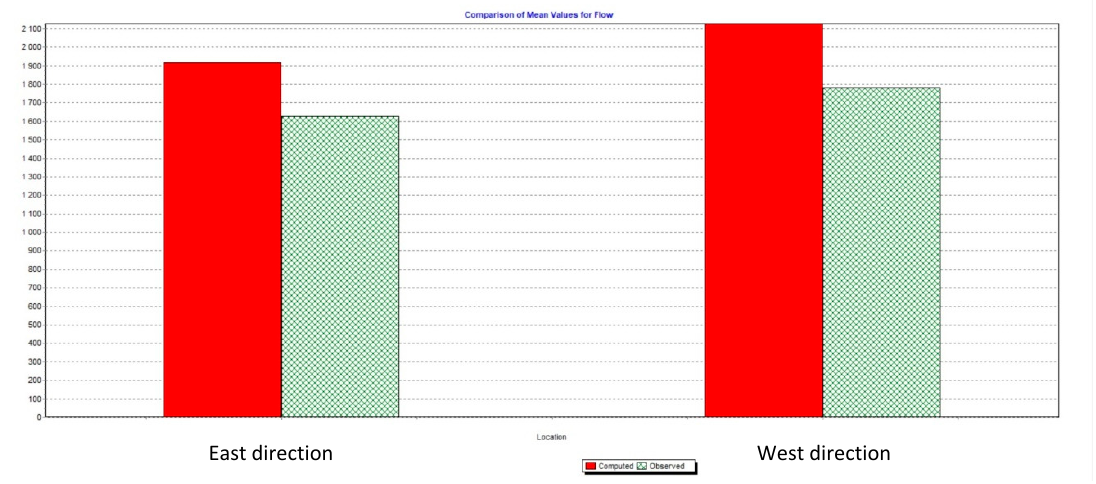
Figure 14. Simulation results for Scenario III.